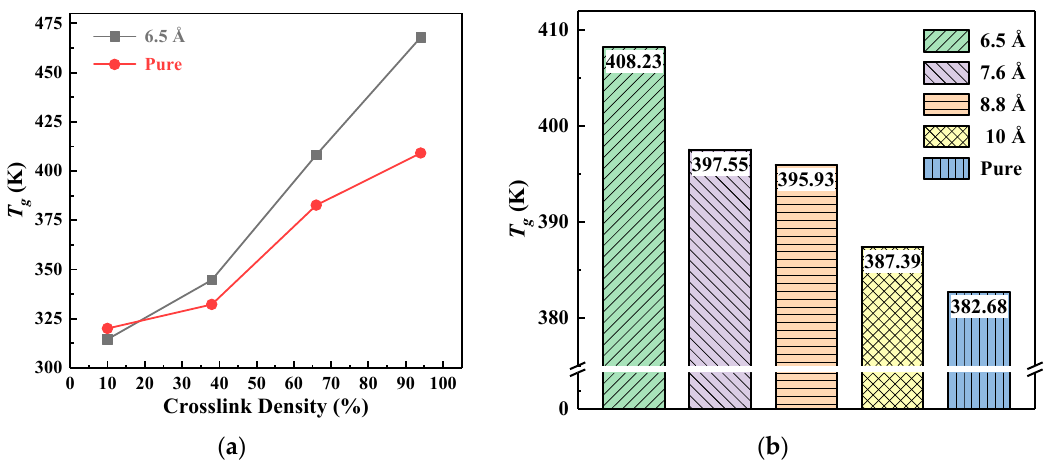
Figure 7. The T g value of EP and its composites. ( a ) The T g value of pure EP and EP composite with 6.5 Å nano-SiO 2 at different crosslinking densities; ( b ) the T g value of pure EP and EP composite with different particle sizes at 67% crosslinking density.